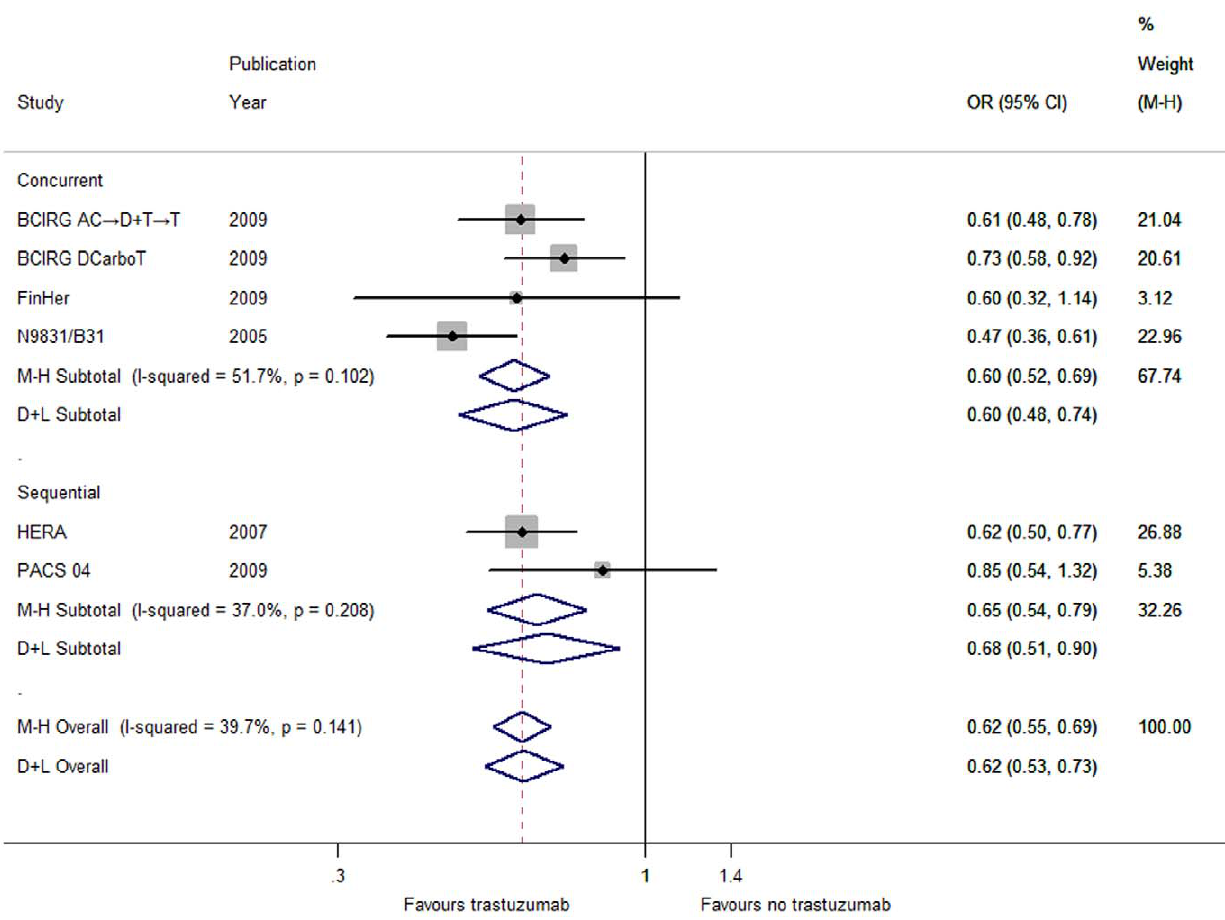
Figure 2. Forest plots of OR for the association between trastuzumab administration and distant recurrence by the timing of trastuzumab initiation with respect to chemotherapy (including the DCarboT arm of the BCIRG 006 trial). The size of the square box is proportional to the weight that each study contributes in the meta-analysis. The overall estimate and confidence interval are marked by a diamond. Symbols on the right of the solid line indicate OR . 1 and symbols on the left of the solid line indicate OR , 1. Abbreviations: M-H=Mantel-Haenszel (fixed-effects method); D + L=DerSimonian and Laird (random-effects method).